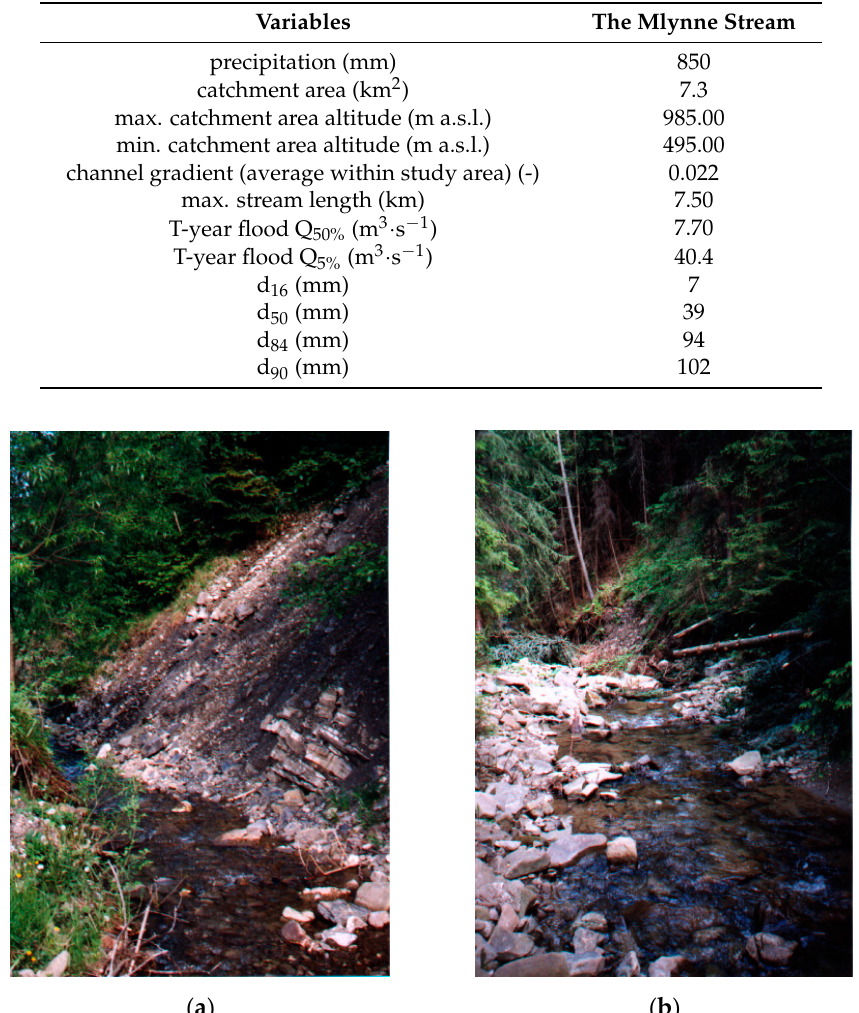
Table 1. Physical characteristics of investigated sites the Mlynne Stream.